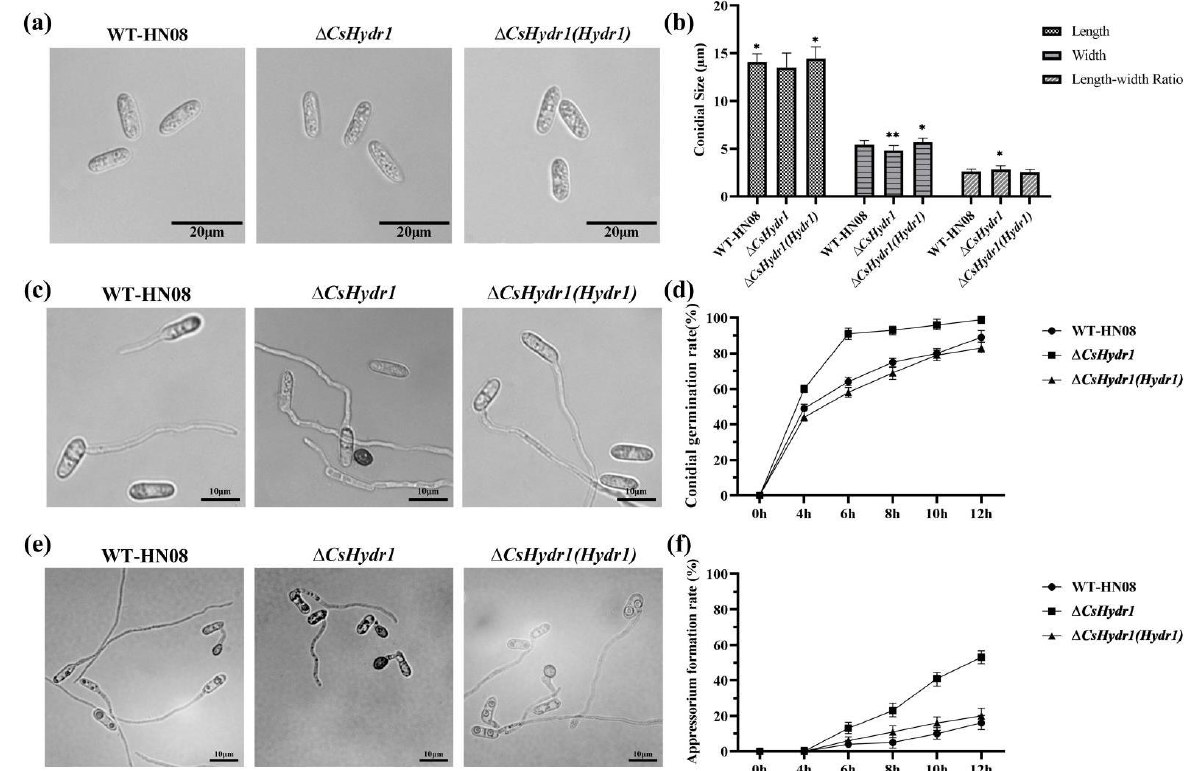
Figure 3. Comparison of conidial size, germination rate and appressorium rate of wild-type HN08, ∆ csHydr1 mutant, and ∆ csHydr1 ( Hydr1 ) strain. ( a , b ) are the morphology, and conidial size of the tested strains; ( c , d ) are morphology and conidial germination rates of the tested strains; ( e , f ) are morphology and appressorium formation rates of the tested strains. * indicated significant differences within each measurement group (* p < 0.1, ** p < 0.01, One-way Anova and Duncan’s test).